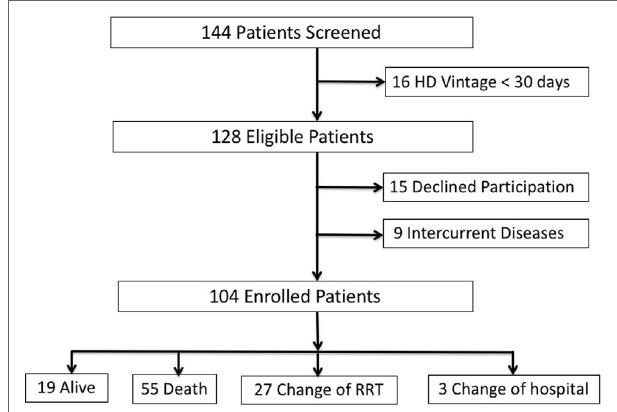
FigUre 1 | Flow-chart. Abbreviations: HD, hemodialysis; RRT, renal replacement therapy.